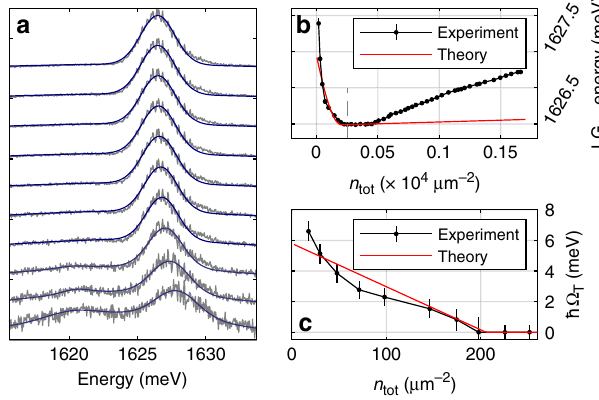
Fig. 3 Trion-polariton nonlinearity. We consider large cavity – exciton detuning δ C – X = − 15.4 meV. a Spectra of the MPB and LPB for the excitation power from 5 to 50 nW (power increases from bottom to top). The MPB and LPB peaks are fi tted with Gaussians. The fi tting of the exciton-like LPB peak (lower energy peak) is performed for the fi rst 4 powers, since it becomes broad and weak at higher densities and the fi tting procedure is not reliable. b Extracted peak positions of the MPB mode vs estimated total exciton-trion density. c Trion-polariton Rabi-splitting vs exciton-trion density. Red solid curves in b , c correspond to the theoretical modelling results. The error bars [95% con fi dence interval (CI)] are estimated taking into account the random error in determination of the peak positions in a as well as possible systematic error ( ΔΩ T ~ 0.5 meV) due to the uncertainty of the fi tting parameters in the coupled oscillators